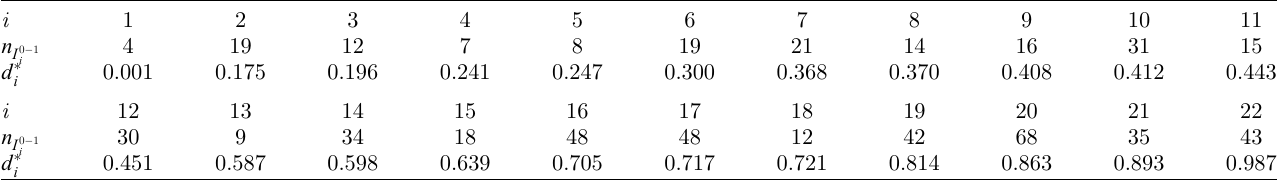
Table 11. Description of the k I = 22 irregular clusters I 0 (cid:3) 1 values reported from left to right in increasing order. Using the process ( Y i,t ) t – see equation (5).